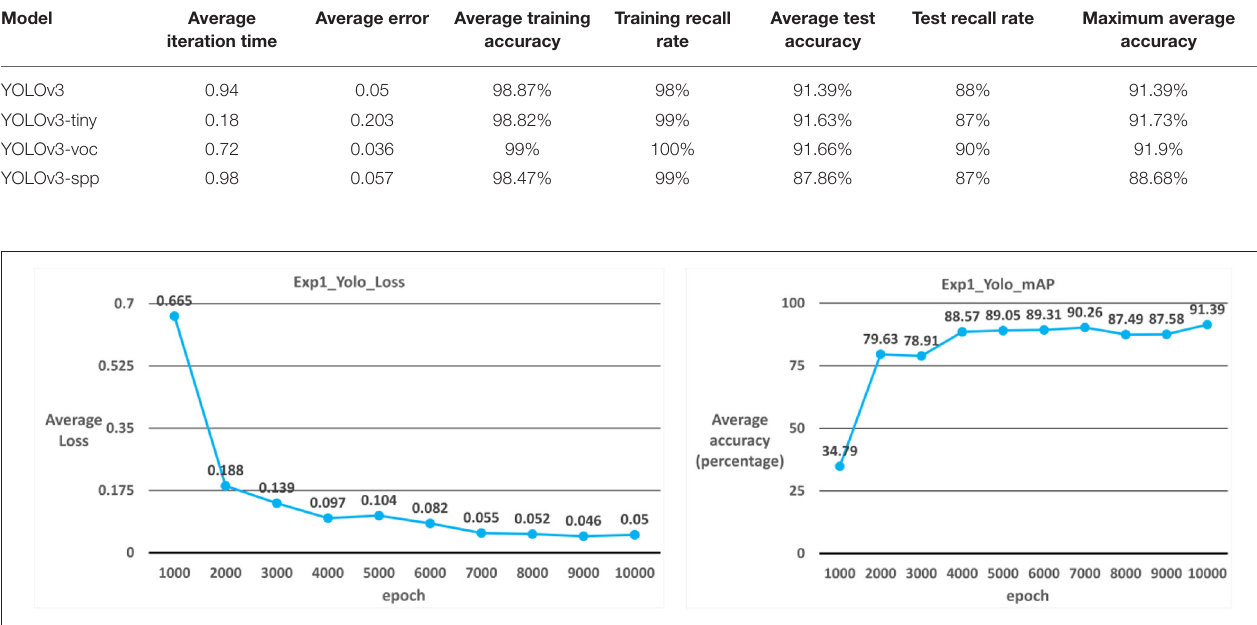
FIGURE 5 | YOLOv3 average error rate and average accuracy